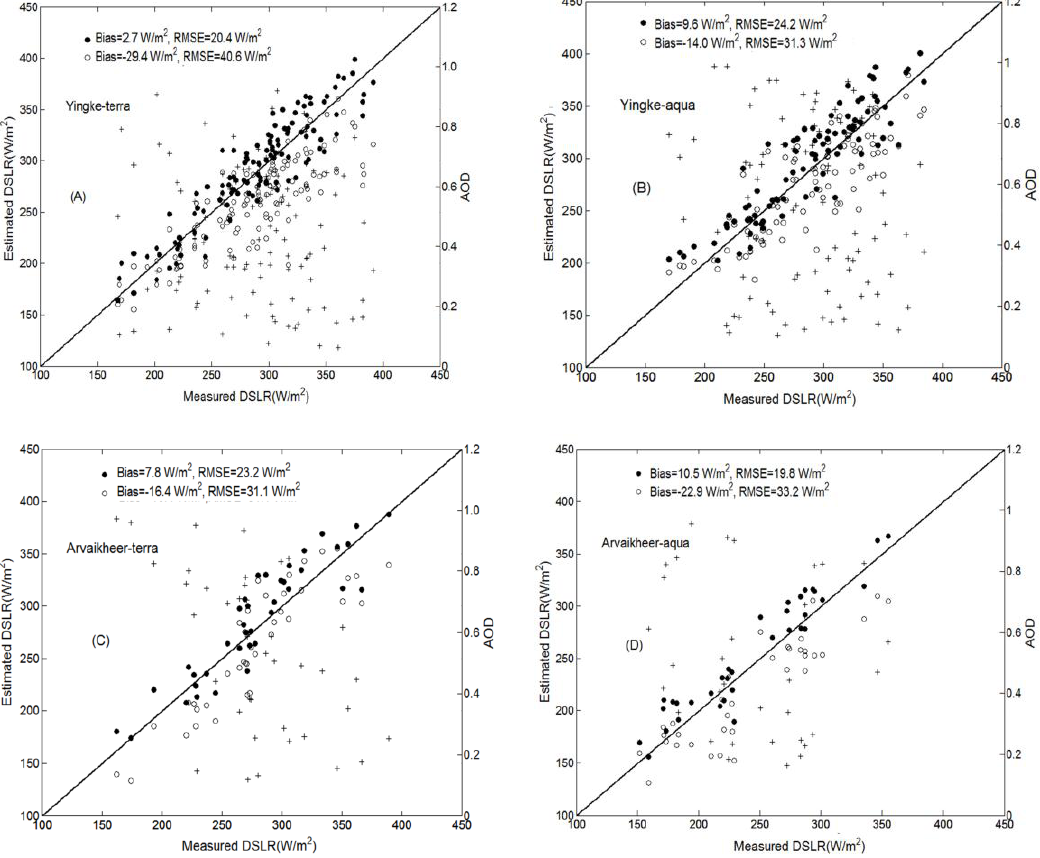
Figure 11. Comparisons between the DSLR estimated using the proposed (solid circles) and DSLR cl methods (hollow circles) and those groundbased measurements at two test sites for dust aerosol conditions at the moment of MODIS overpass. The scattering diagrams of the AOD (hollow plus signs) as function of the measured DSLR are also shown. ( A ) Yingke-terra; ( B ) Yingke-aqua; ( C ) Arvaikheer-terra; ( D ) Arvaikheer-aqua.